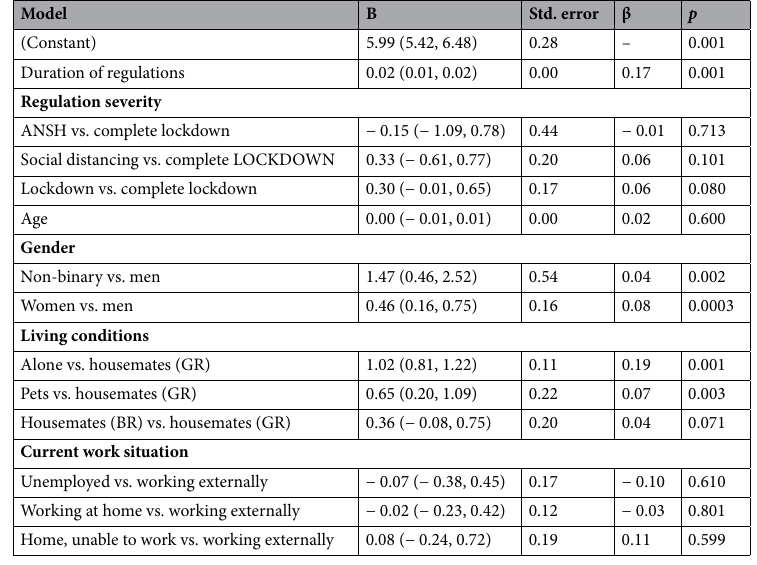
Table 2. Regression coefficients with longing for touch as outcome measure. Multiple linear regression model (95% bias-corrected and accelerated CI reported in parentheses). Confidence intervals and standard errors